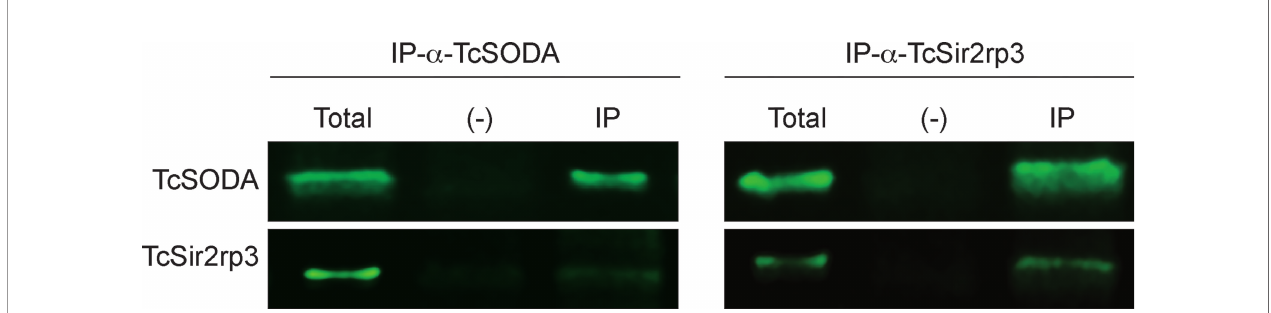
FIGURE 5 | Interaction of TcSir2rp3 and TcSODA proteins. Immunoprecipitated samples with anti-TcSODA (left) or with anti-TcSir2rp3 (right) of total protein extracts of WT parasites were submitted to Western blot analyses with anti-TcSir2rp3 and anti-TcSODA. The two proteins, TcSir2rp3 and TcSODA, were detected in the immunoprecipitated fractions (IP). No signal was detected in the negative control samples ( − ) immunoprecipitated with anti-aldolase. Experiments were performed in triplicate, and the fi gure is a representative of the results